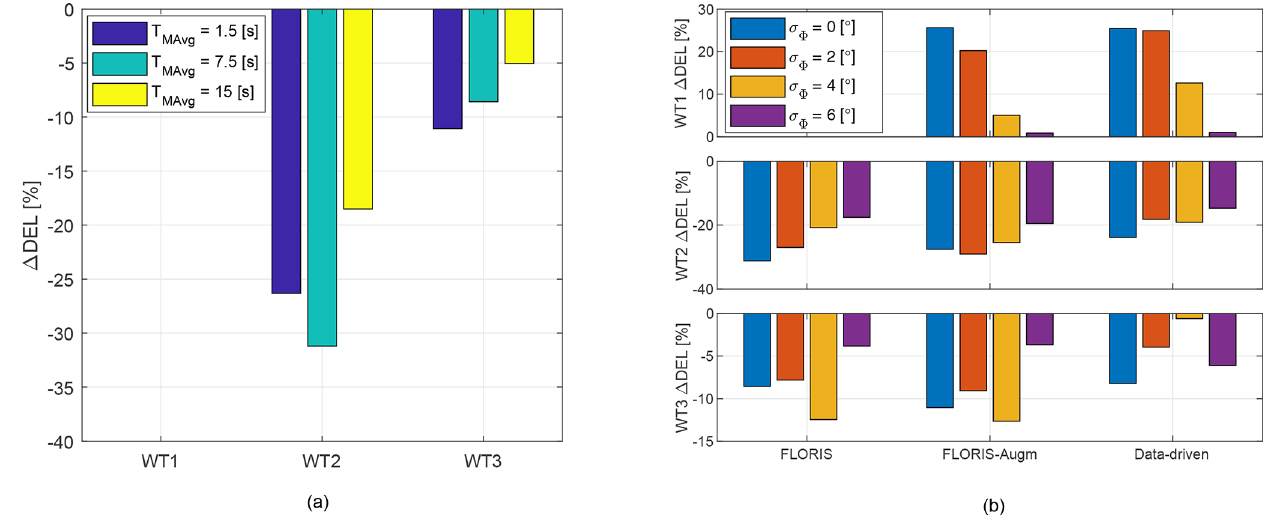
Figure 19. Change in combined tower base DELs with respect to the greedy case. (a) Effect of direction uncertainty: non-robust LUT for the baseline FLORIS model and varying T MAvg . (b) Effect of robustness and model fidelity: LUTs for the three models and increasing robustness, for a wind direction signal filtered with T MAvg = 7 .